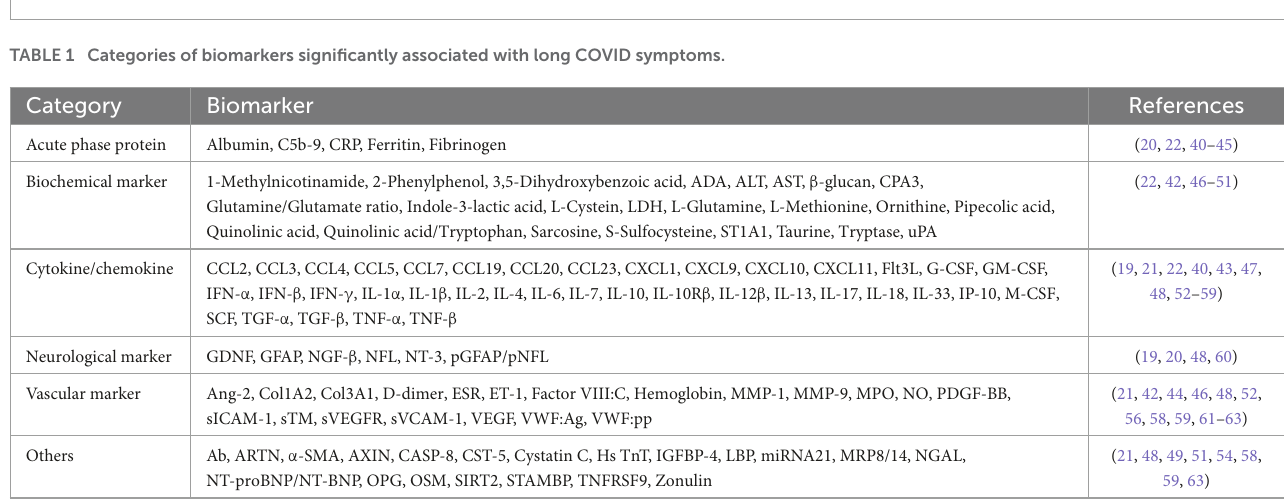
FIGURE2 Study quality of the 28 articles in the systematic review assessed by the modified REMARK questionnaire ( Supplementary Table 3 ).